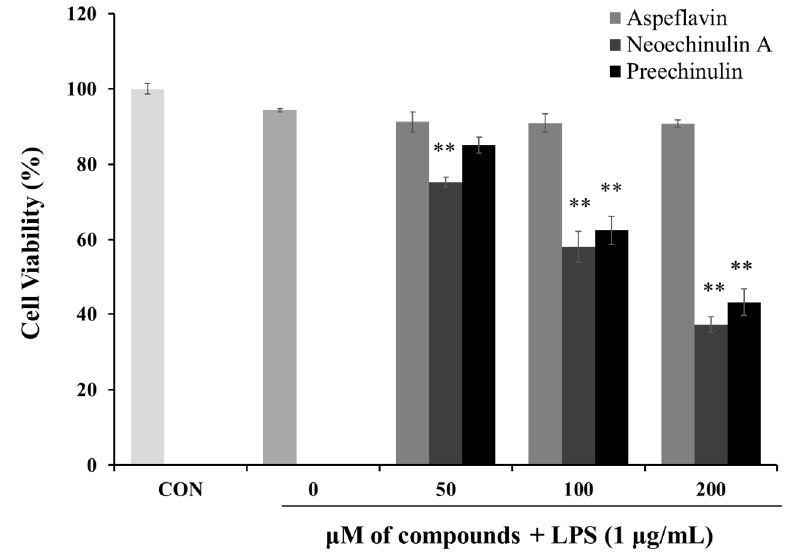
Figure 4. Cytotoxicities of asperflavin, neoechinulin A and preechinulin on cell viability in LPS-stimulated RAW 264.7 cells. RAW 264.7 cells were cultured with the different concentrations (50, 100, and 200 μ M) of the compounds and LPS (1 μ g/mL) for 24 h. Each value indicates the mean ± S.D. and is representative of results obtained from three independent experiment. ** p < 0.01 indicates significant differences from the LPS-stimulated group.